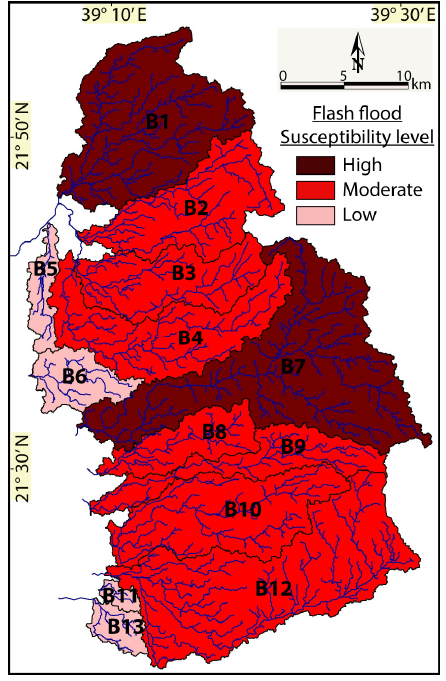
Figure 7. Map of relative flood susceptibility of the basins.